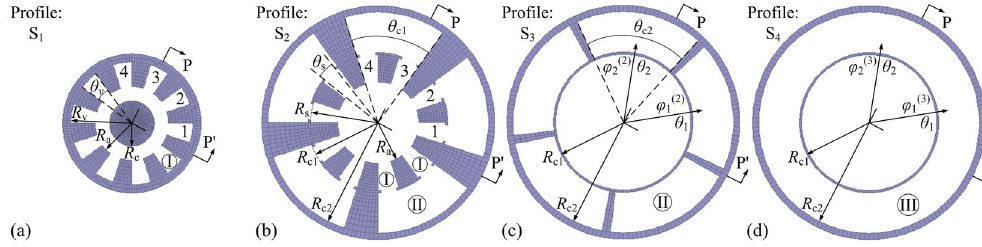
Figure 2. Schematic diagram of the transversal profiles of the RM in the ( a ) S 1 plane, ( b ) S 2 plane, ( c ) S 3 plane, and ( d ) S 4